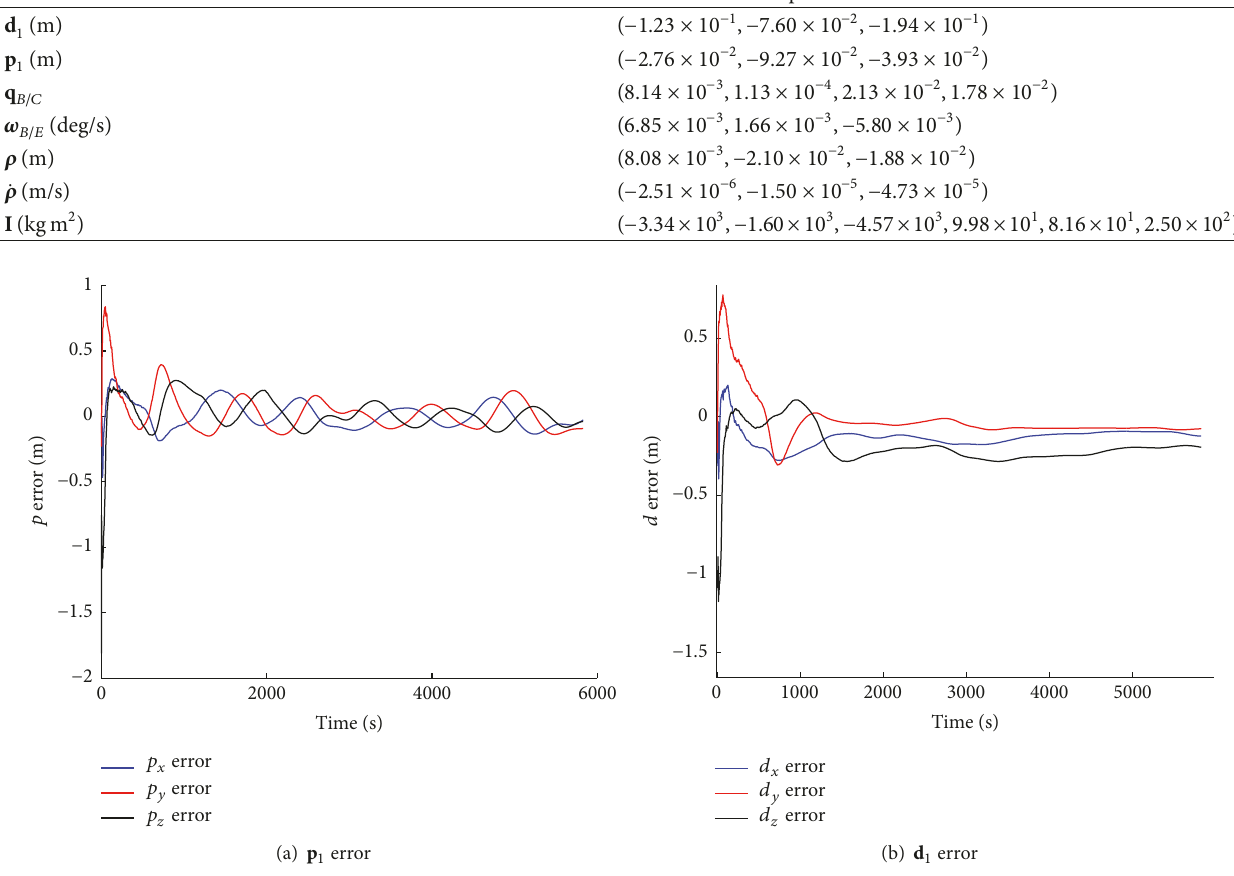
̂ d p 1 (m). (b) 1 estimation errors in components: